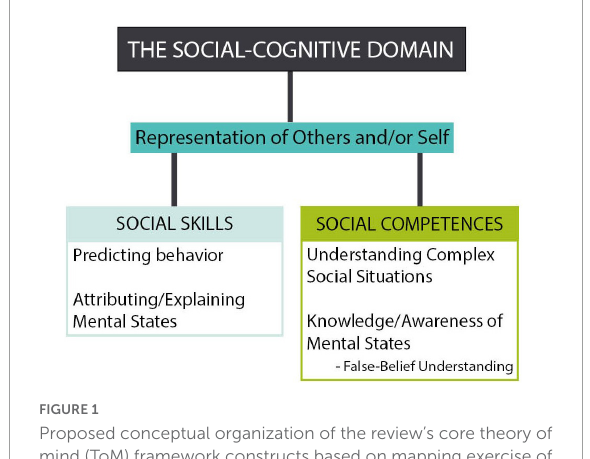
FIGURE1 Proposed conceptual organization of the review’s core theory of mind (ToM) framework constructs based on mapping exercise of school-based social skills intervention outcomes onto the ToM framework. For reference, the seven constructs part of the original ToM framework used in the review’s mapping exercise included: (1) Attribution/explanation of mental states; (2) False-belief understanding; (3) Knowledge/awareness of mental states; (4) Predicting behavior; (5) Representation of others and/or self; (6) Social competence; (7) Understanding complex social situations. Constructs are listed in alphabetical